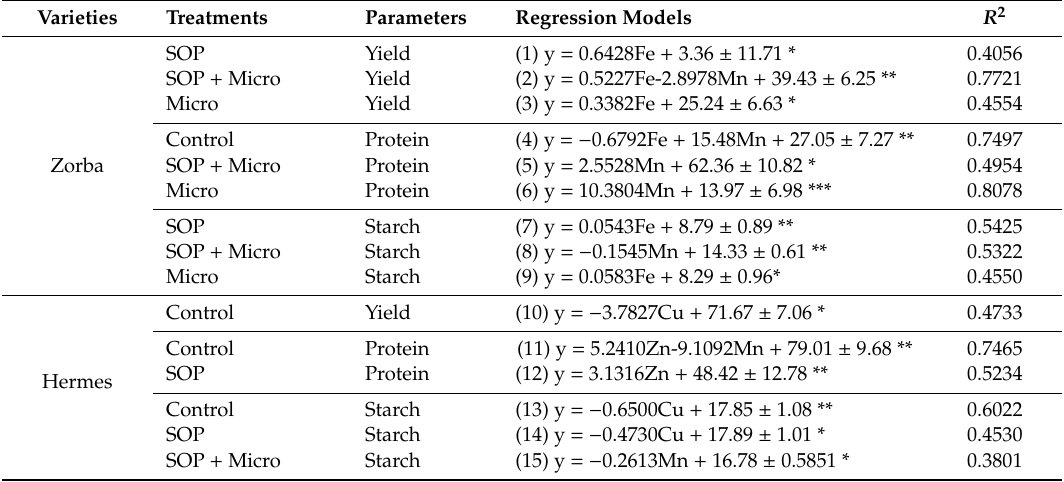
Table 2. Regression models of potato yield, protein and starch as the function of microelement content at the stage of full